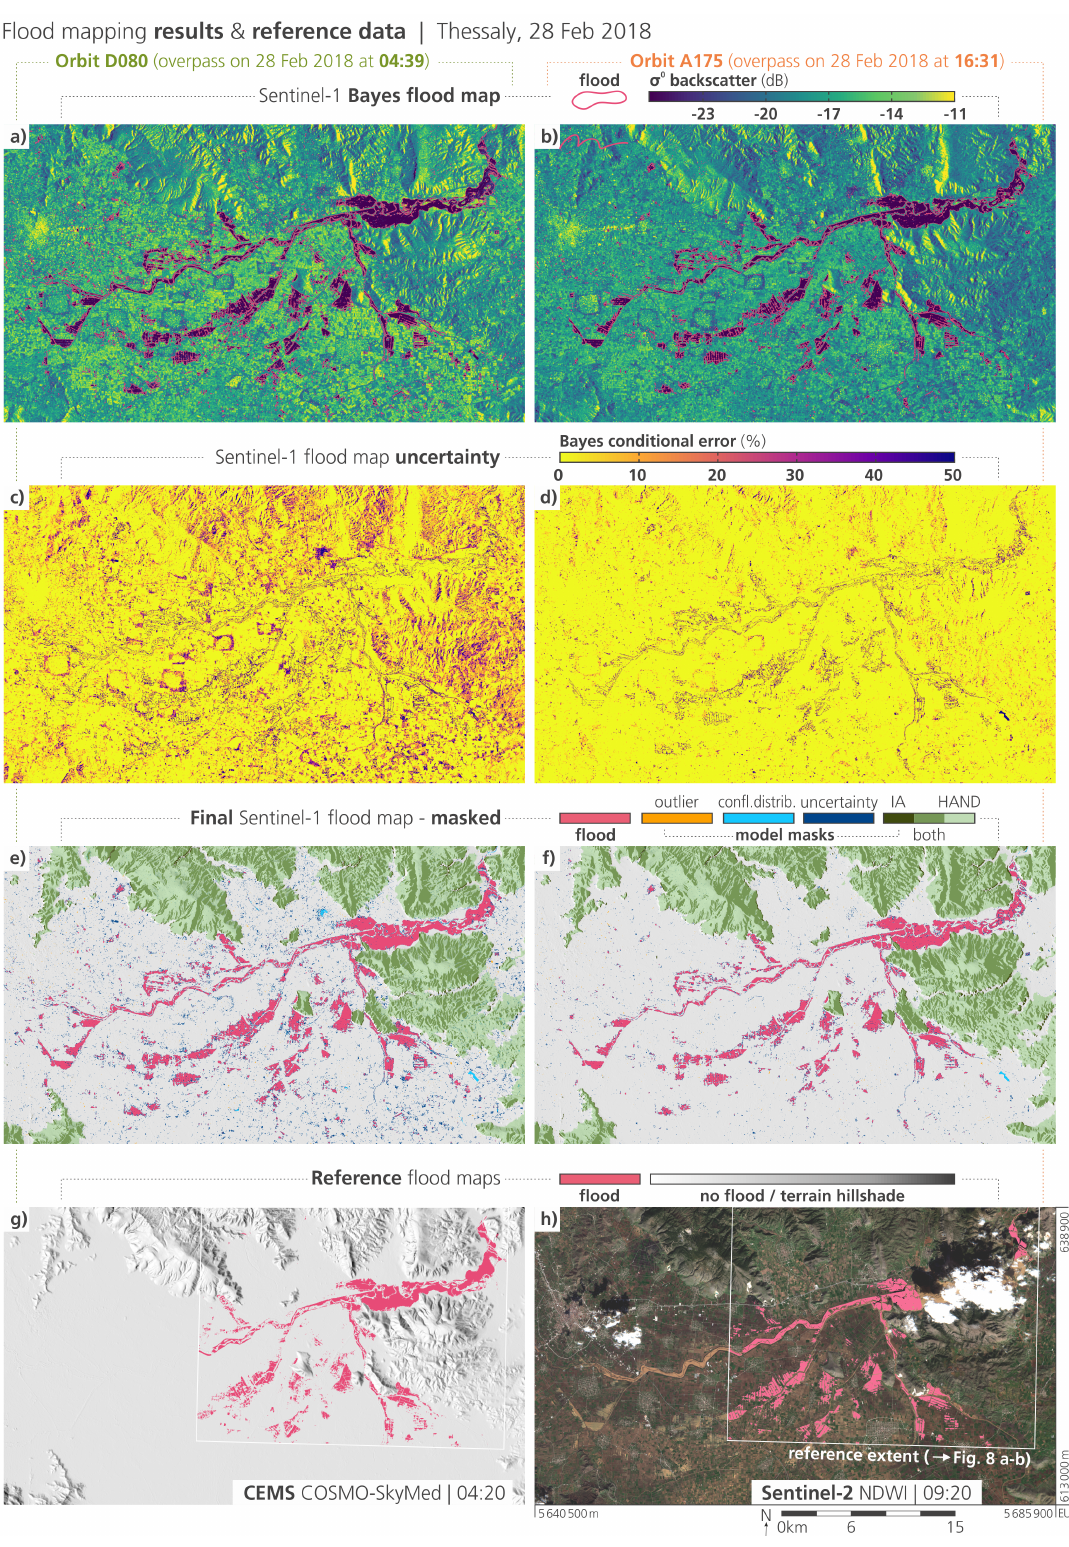
Figure 7. Array of Bayes flood mapping results versus reference flood maps from ( g ) CEMS and ( h ) Sentinel-2. ( a , b ) Sentinel-1 backscatter images from two overpasses on 28 February 2018, overlaid with the outline of the Bayes flood classification. ( c , d ) Uncertainty values (i.e., conditional errors) of the Bayes decision. ( e , f ) Final Bayes classification results after postprocessing and masking (subject to